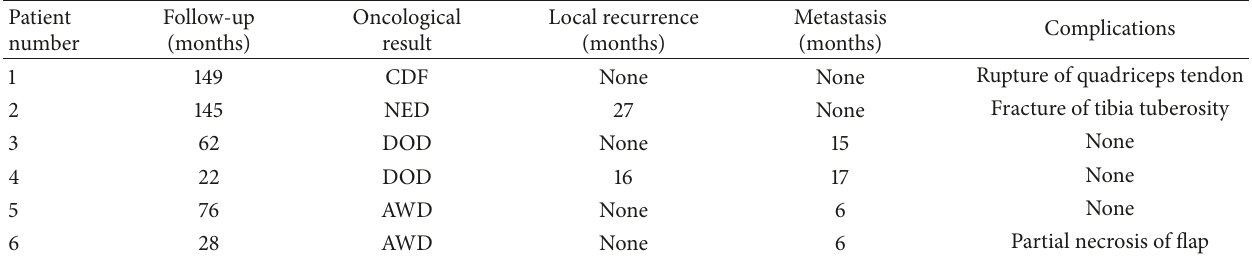
Table 2: Oncological results and complications.